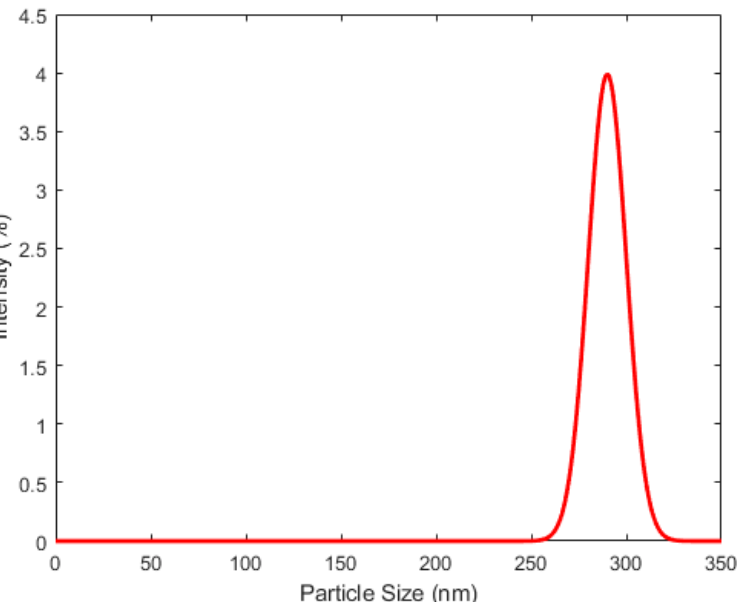
Figure 1. Hydrodynamic size of P(St/AA) latex particles measured in 1 mM NaCl and at 20 °C. Additionally, the surface charge of the particles was proven to be around − 50 mV. The morphology of the particles was examined using both scanning and transmission electron microscopy (SEM) and transmission electron microscopy (TEM), as shown in Figure 2A,B, respectively. It was found that the particles are spherical with a smooth surface. As can be seen from Figure 2B, the average particle size from TEM is around 275 nm; slightly lower than the hydrodynamic size as generally reported. This difference is attributed to the difference between the analysis in dispersed media based on Brownian motion and the measurement of the dried sample by TEM.